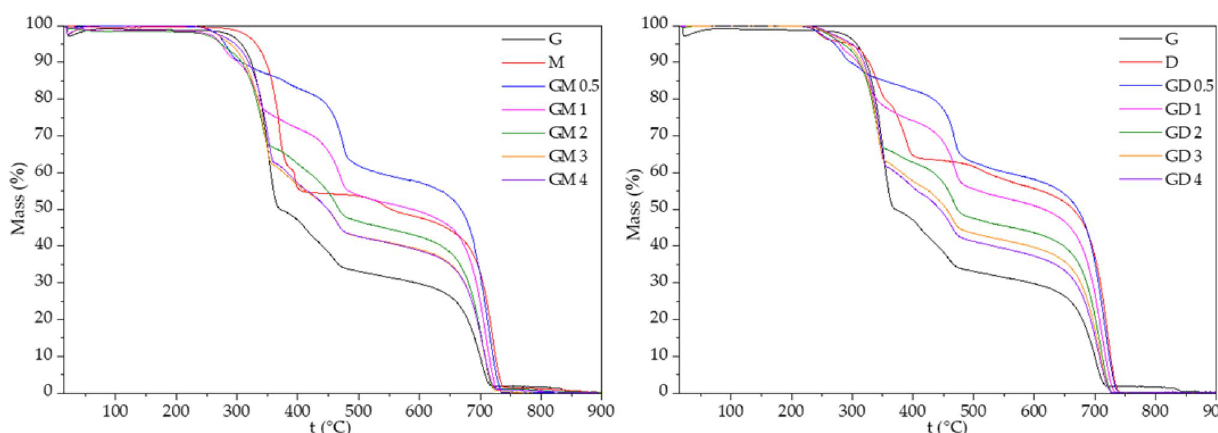
Figure 14. TGA curves of CN